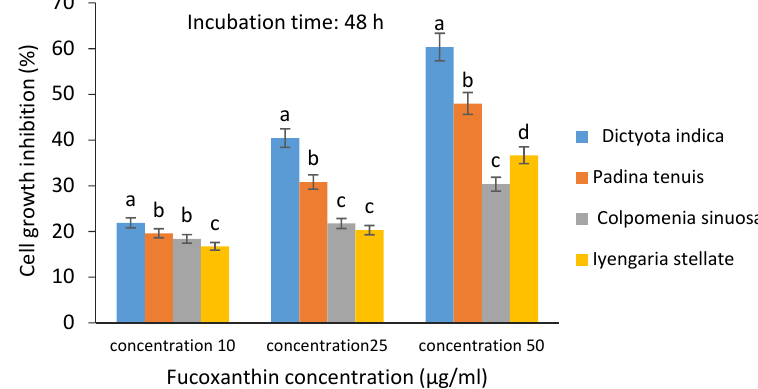
Fig. 4: Percentages of cell growth inhibition at different concentrations of fucoxanthin extract from four species of brown seaweeds (P. tenuis , C. sinuosa , I. stellate and D.Indica) at 48 h incubation time Data are expressed as mean±standared deviation (n=3). Different letters (a, b, c, d) indicate significant mean differences between seaweeds species at a level of p < 0.05.